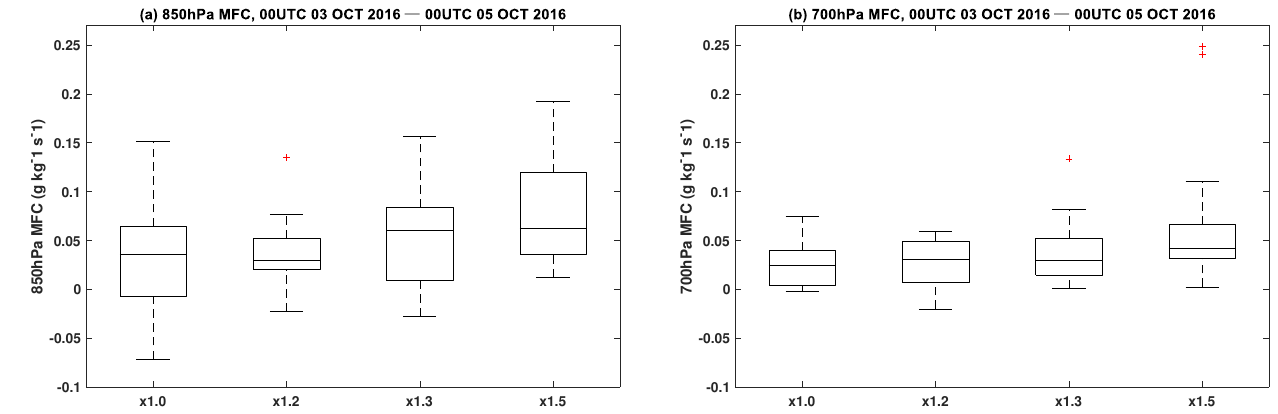
Figure 10. The box-whisker plots of the hourly moisture convergences at the 850 hPa ( a ) and 700 hPa ( b ) averaged 3 degrees around the TC center for 3 October 00 UTC to 5 00 UTC. Table 2. Correlation coefficients (r) and p -values between TC central pressure and the 850-hPa & 700-hPa moisture flux convergence for each experiment. The bold number denotes statistical significance at the 95% confidence